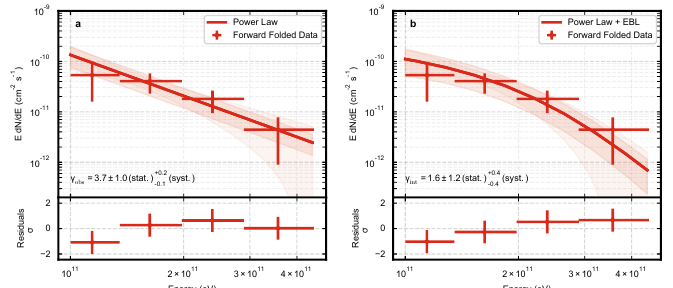
Figure 15. GRB180720B: spectral fit to the observed emission in the 0.1–0.44TeV energy range. In the left panel ( a ), the observed spectrum is assumed to be described by a power-law model, while in the panel on the right ( b ), the spectrum is an power-law attenuated by EBL. Statistical and systematic uncertainties at a 1 σ confidence level are shown with shaded areas. From